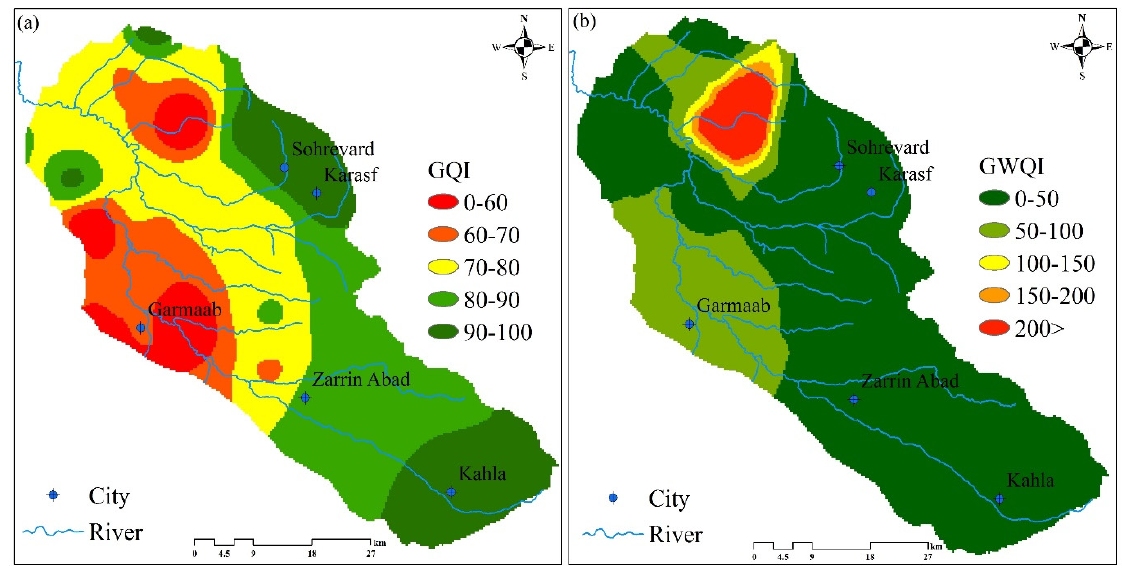
Figure 5. Maps of water quality indices: ( a ) GQI; ( b ) GWQI.